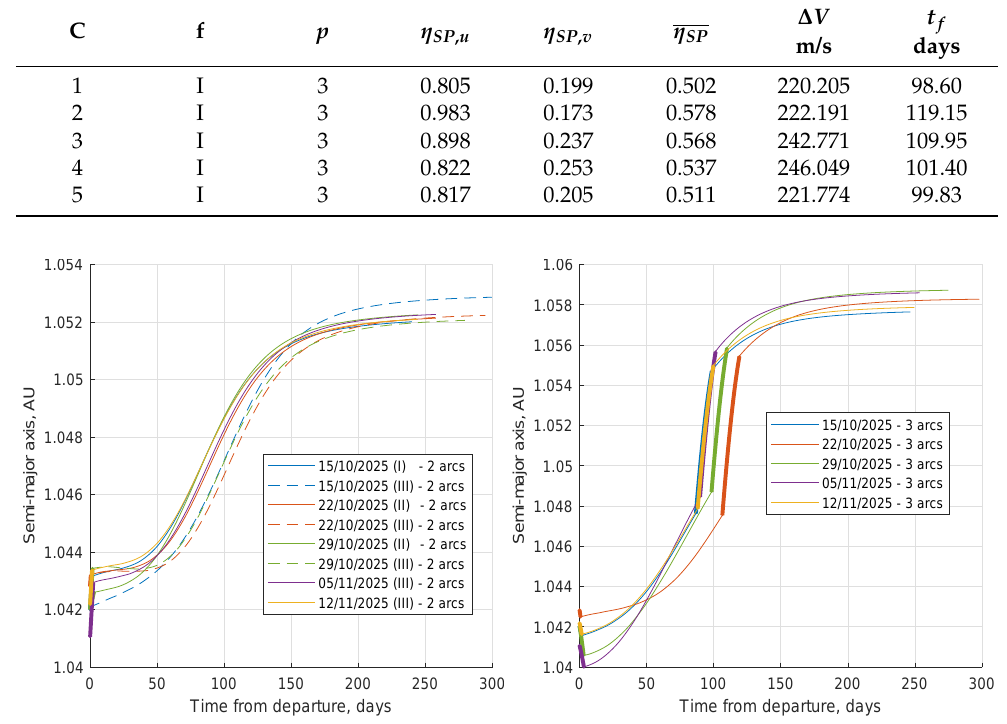
Figure 12. SEL2 selected escapes—spacecraft semi-major axis in the heliocentric ecliptic RF—fixed C 3 = 0.2 (km/s) 2 ( left ), 0.5 (km/s) 2 ( right ) − 2.5 × t f